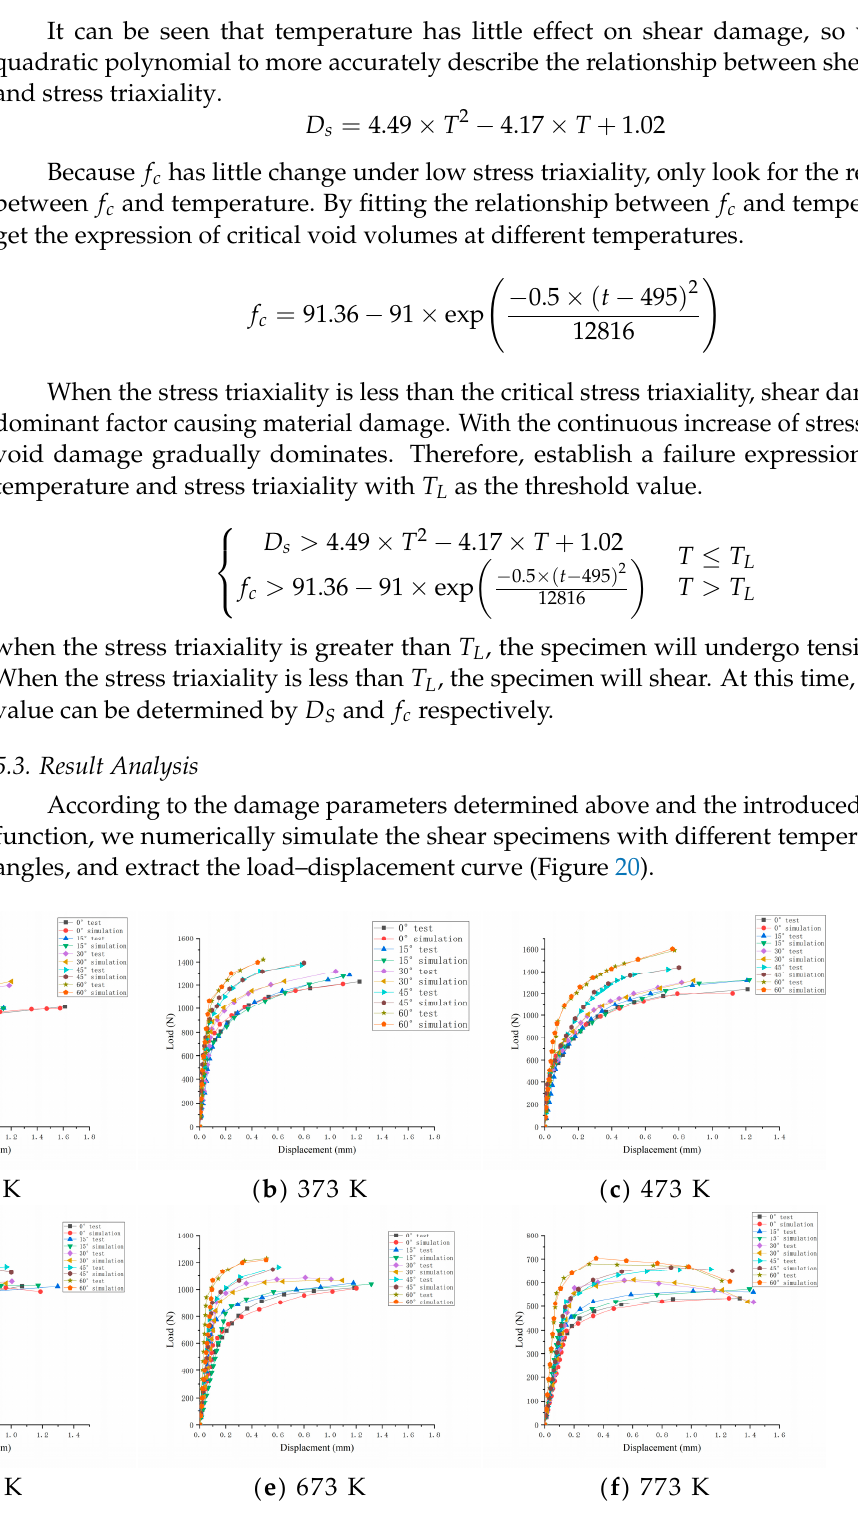
Figure 20. Comparison between numerical simulation and test load–displacement curves at different temperatures ( a – f ).